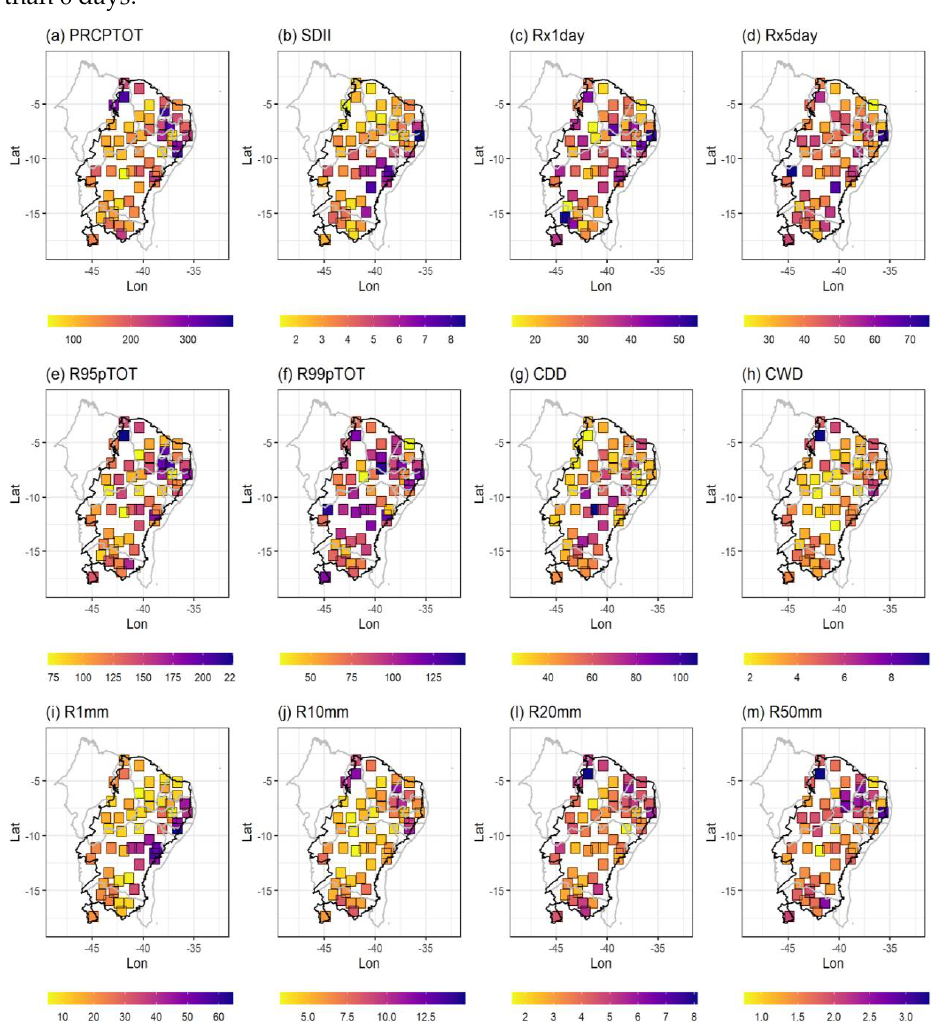
Figure 5. RMSE between climate indices derived from IMERG and rain gauges over a period of 21 years (2000–2020), ( a ) PRCPTPT, ( b ) SDII, ( c ) Rx1day. ( d ) Rx5day, ( e ) R95pTOT, ( f ) R99pTOT, ( g ) CDD, ( h ) CWD, ( i ) R1mm. ( j ) R10mm, ( l ) R20mm, ( m )